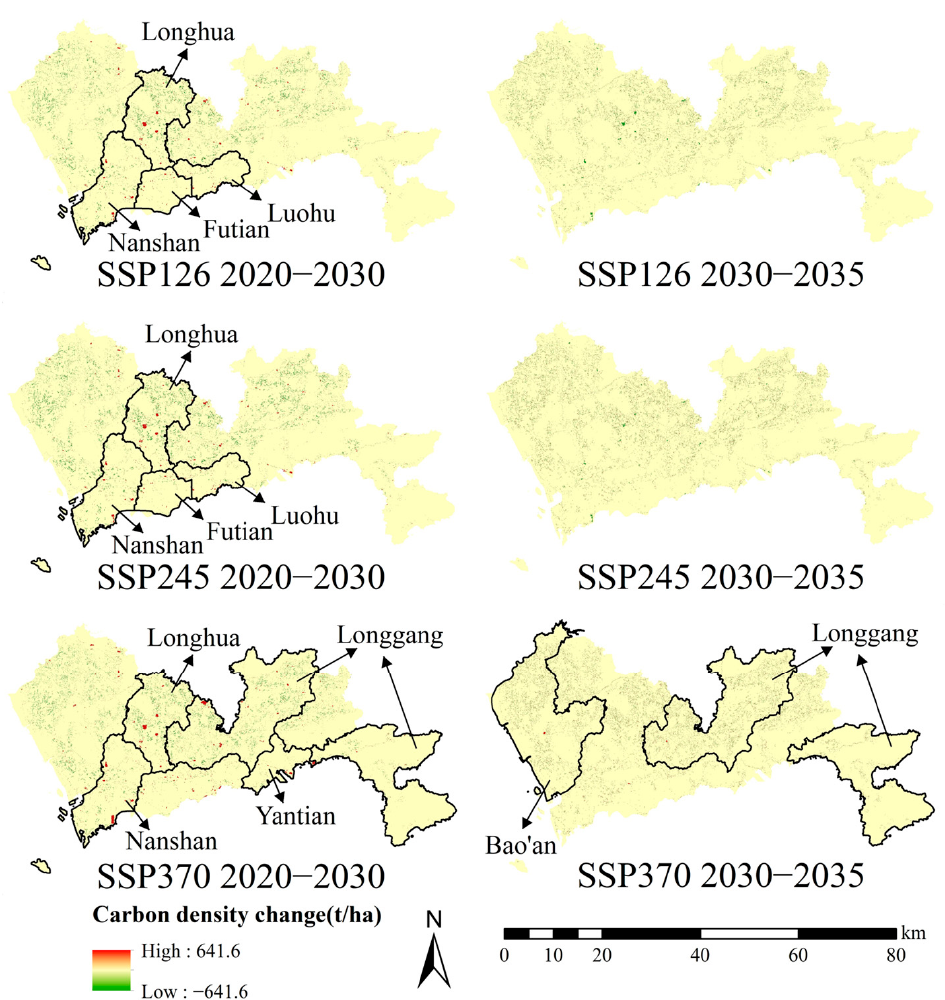
Figure 7. Carbon density change for 2020–2030 and 2030–2035 under SSP-RCP scenarios. Note: The left column represents the carbon intensity change from 2020 to 2030 under SSP-RCP scenarios and the right column represents the carbon intensity change from 2030 to 2035 under SSP-RCP scenarios.